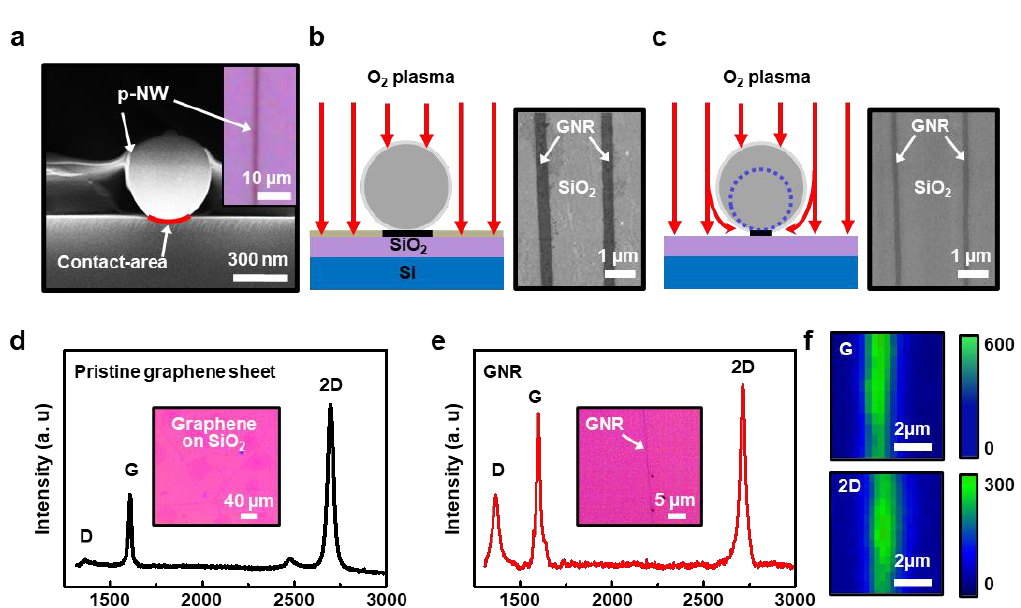
Figure 3. ( a ) SEM image of the side view of a p-NW; contact area was marked in red, and the inset shows an optical micrograph of a single p-NW on a graphene sheet. ( b , c ) O 2 plasma process to remove the unprotected graphene sheet to engrave GNR arrays with different processing conditions. ( d ) Typical Raman spectrum of the graphene sheet on a SiO 2 /Si substrate, which indicates a monolayer in the graphene structure. ( e ) Raman spectrum measured from the GNR on a SiO 2 /Si substrate after O 2 plasma and the removal of p-NWs. ( f ) Representative Raman mapping images of a patterned GNR ( w = ~500 nm).